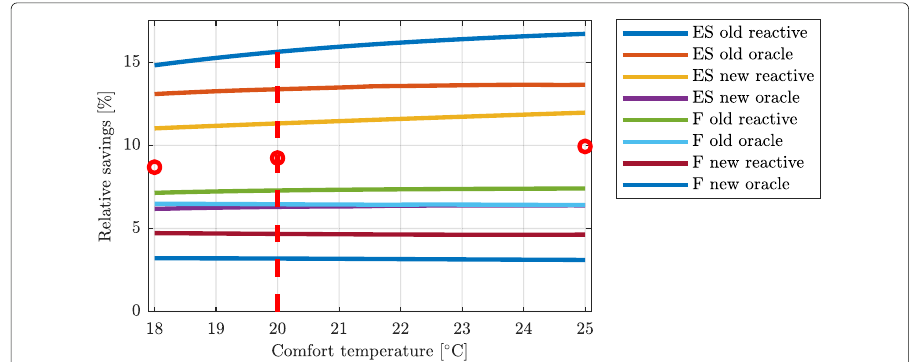
Fig. 8 The relative savings for four types of artificial households (typical schedules for employed singles (ES) and family (F), each of them in both a “new” and “old” dwelling) depending on the comfort temperature setting. The vertical dashed line corresponds to a comfort temperature of 20°C, at which we carried out the main evaluation. The red circles mark the results of repeated simulations for all households in the CER dataset at comfort temperature settings of 18°C, 20°C, and 25°C using the oracle